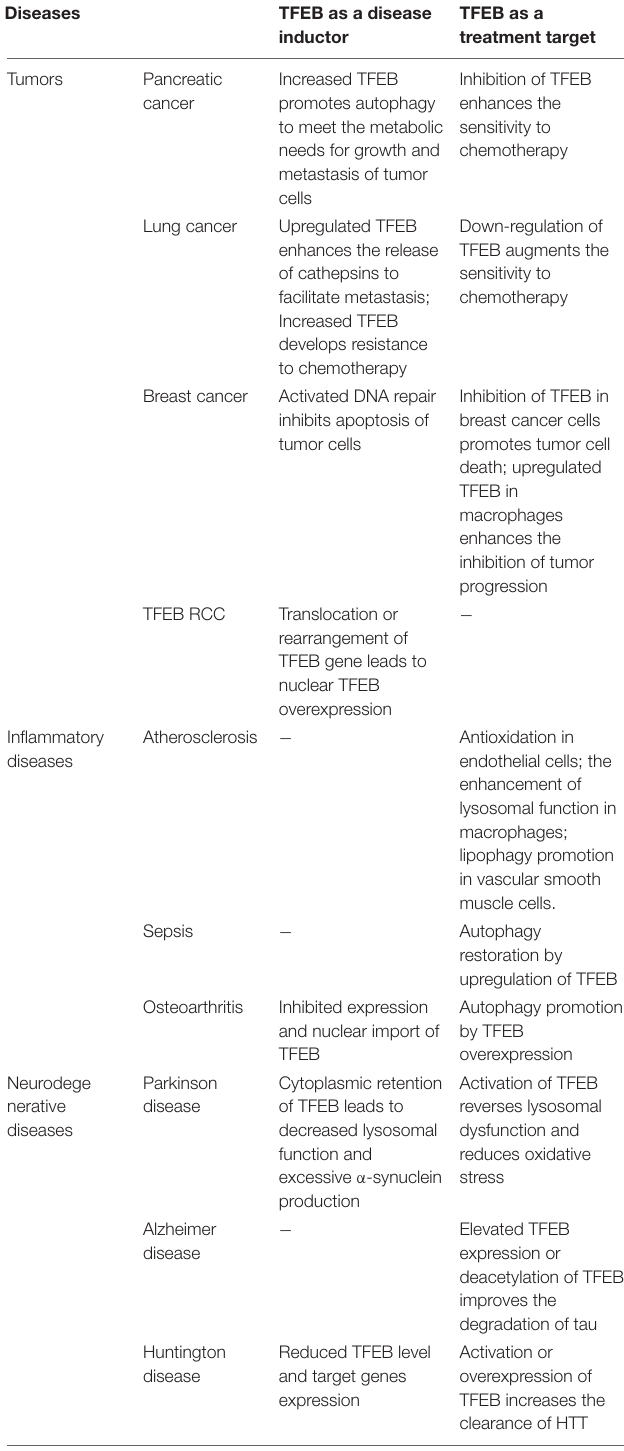
TABLE 1 | TFEB serves as a potential therapeutic target for human